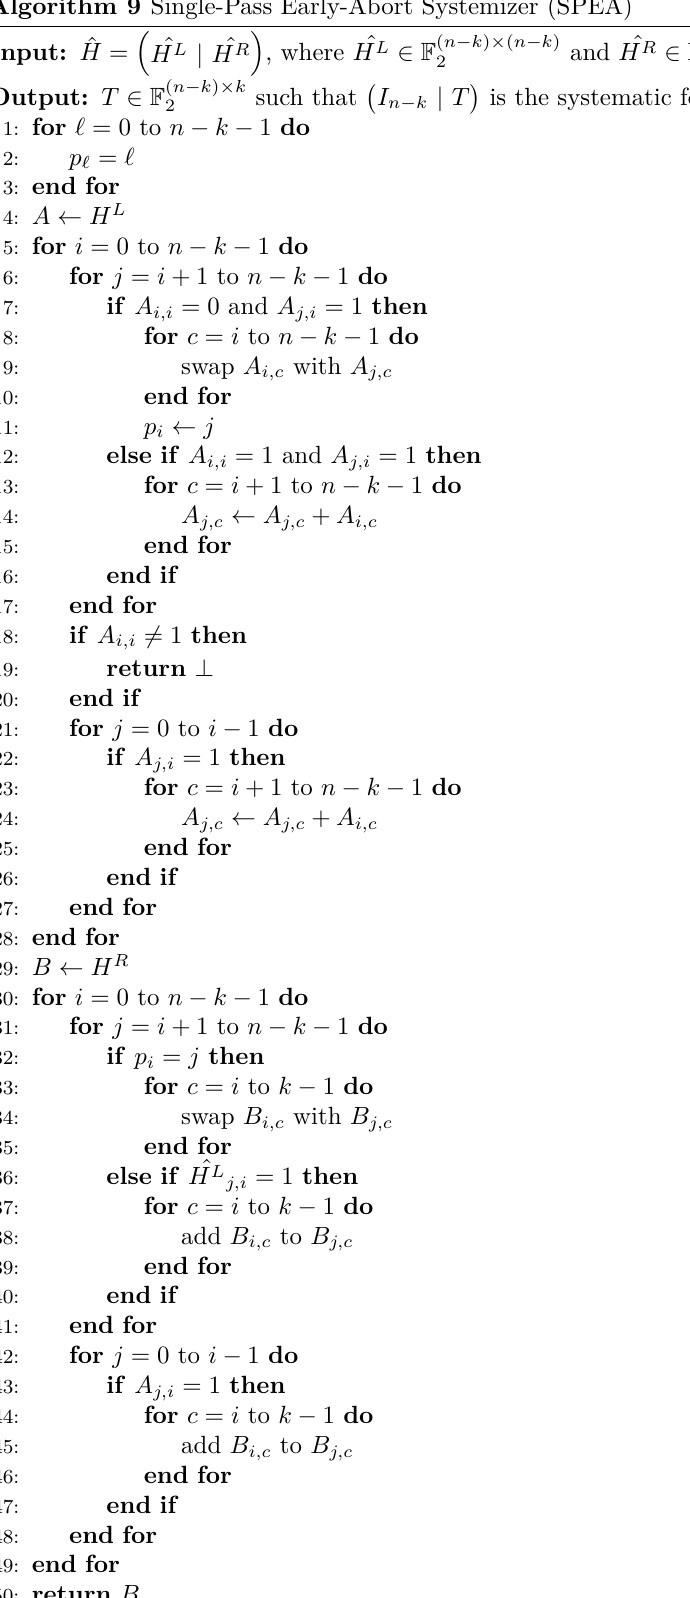
Algorithm 9 Single-Pass Early-Abort Systemizer